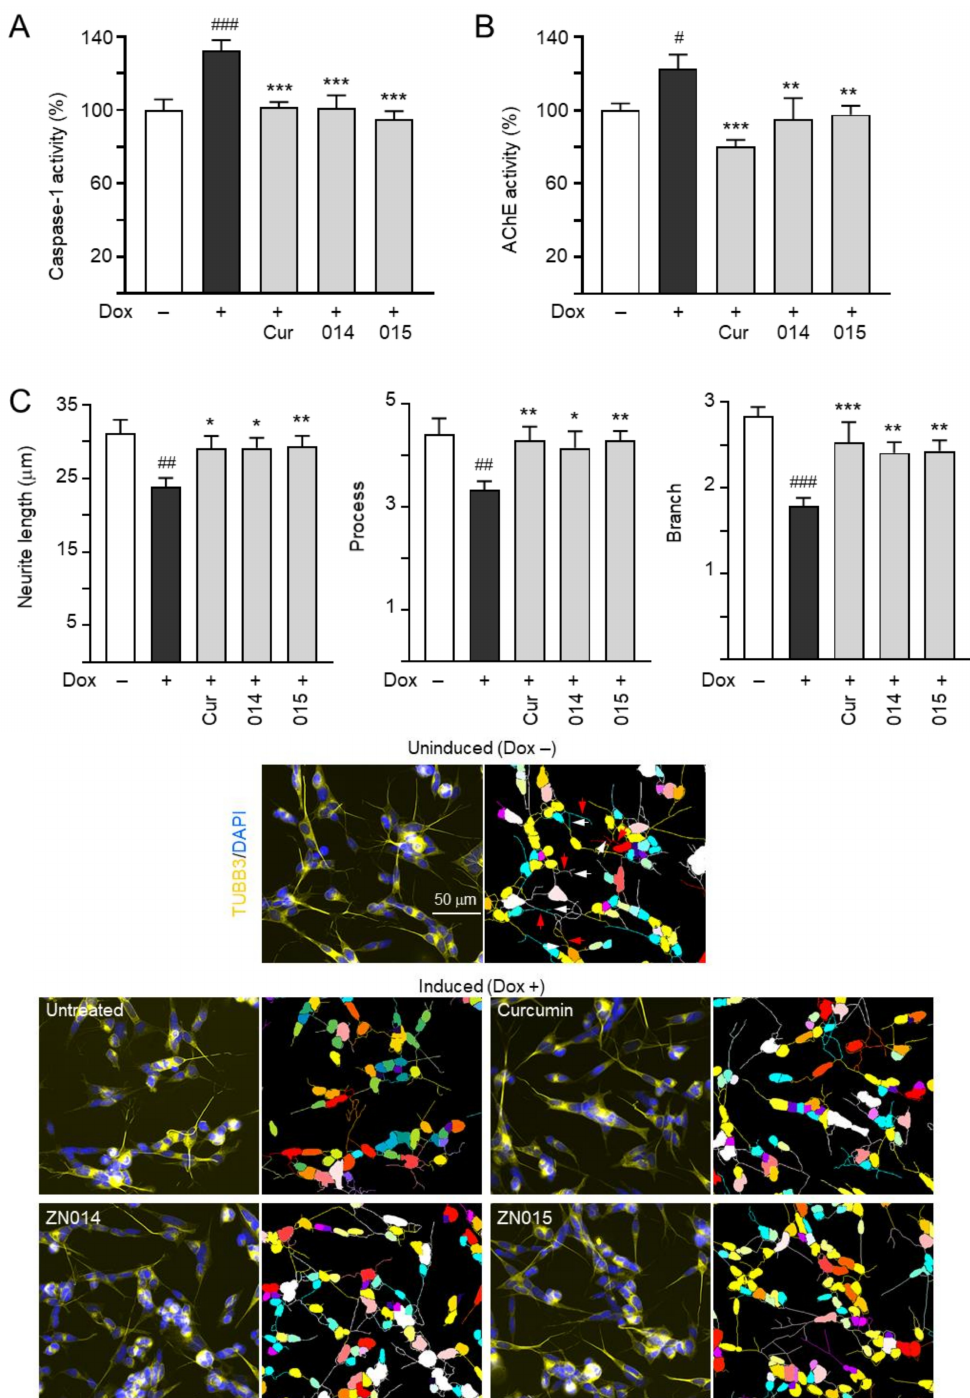
Figure 3. Caspase-1, AChE reduction, and neurite outgrowth promotion of ZN014 or ZN015 in SH-SY5Y cells expressing A β -GFP. As described, cells were seeded with retinoic acid, treated with curcumin, ZN014, or ZN015 (5 µ M), and induced for A β -GFP expression with doxycycline for 6 days. On day 8, ( A ) caspase-1 activity, ( B ) AChE activity, and ( C ) neurite length, process, and branch were analyzed ( n = 3). The relative caspase-1 or AChE activity of uninduced cells (Dox − ) was normalized (100%). Shown at the bottom of ( C ) are images of class III β -tubulin (TUBB3) (yellow)-stained cells, with nuclei counterstained with DAPI (blue), and segmented images with a multicolored mask to assign each outgrowth to a cell body for neurite outgrowth quantification. In uninduced cells, processes and branches are indicated with red and white arrows, respectively. p -values: comparisons between induced vs. uninduced cells ( # : p < 0.05, ## : p < 0.01, ### : p < 0.001) or compound-treated vs. untreated (induced) cells (*: p < 0.05, **: p < 0.01, ***: p < 0.001) (one-way ANOVA with a post hoc Tukey